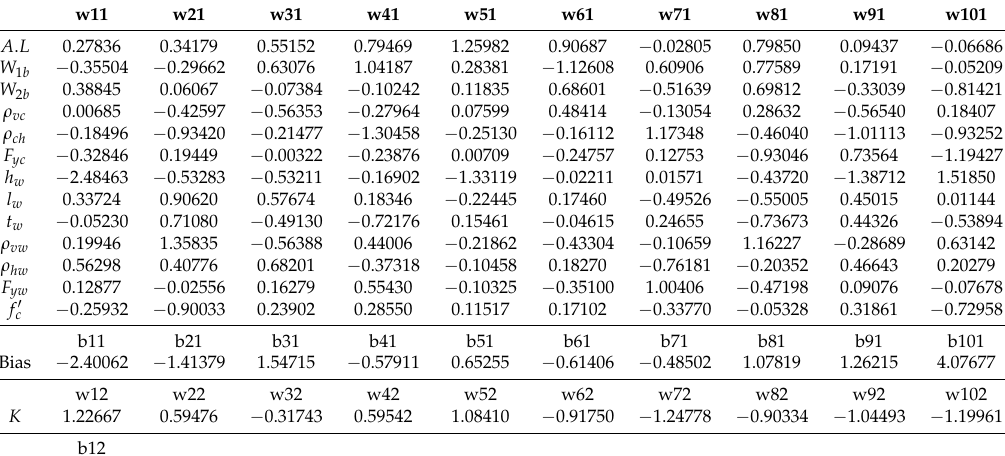
Table A6. Detailed meta-model for stiffness response of RCSW.